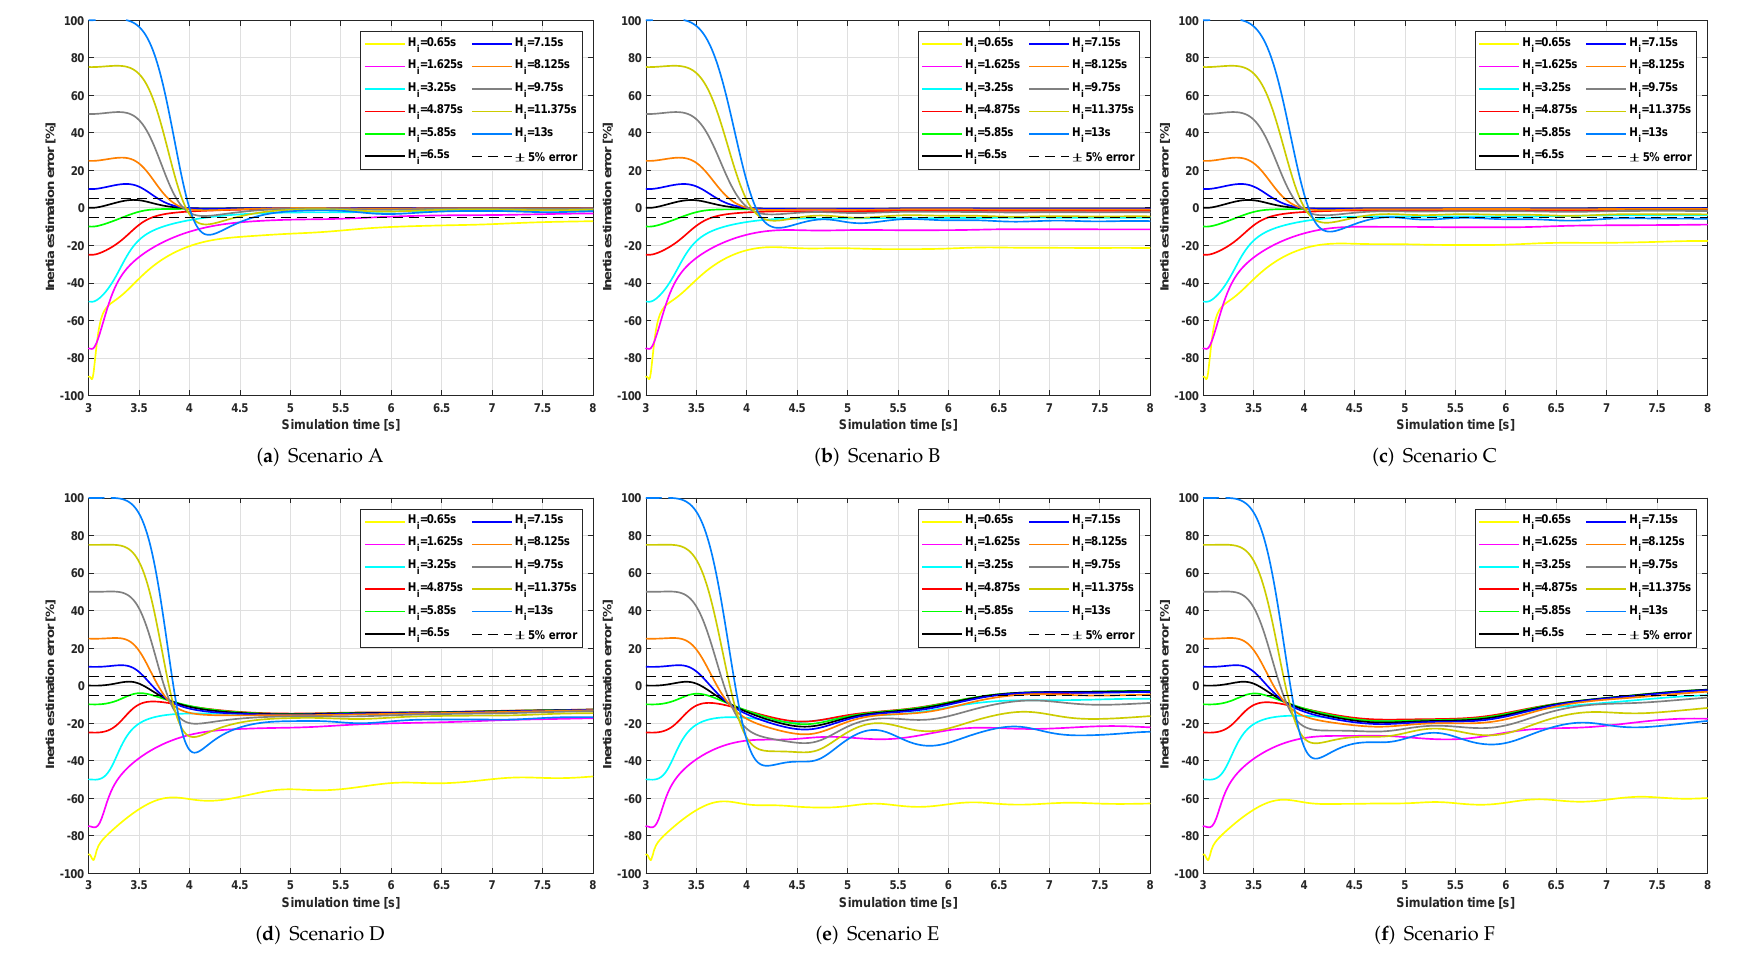
Figure 5. EKF-based inertia estimates, obtained by starting the EKF at the true time of